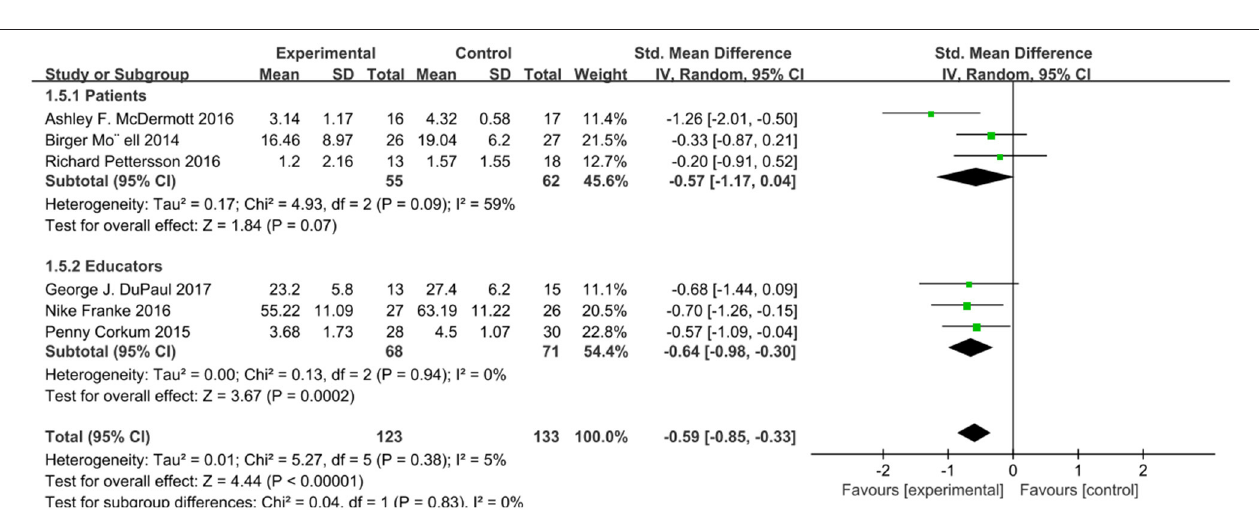
FIGURE 5 | Subgroup analysis of attention score of online intervention ADHD compared with waiting list (for children or adults).